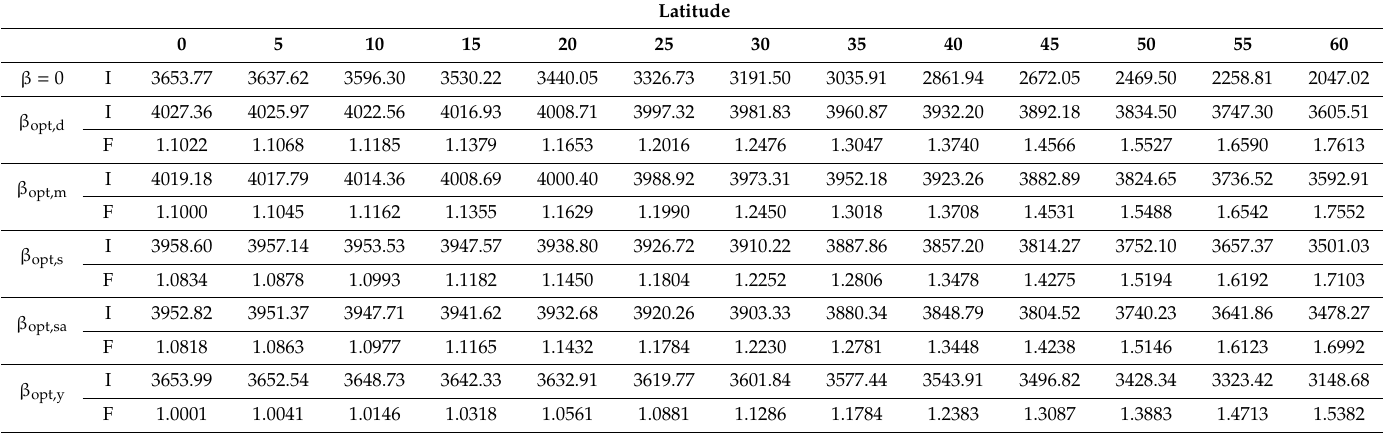
Table 6. The tilt factor for the daily, monthly, seasonal, semi-annual, and annual optimum tilt angles for di ff erent latitudes.